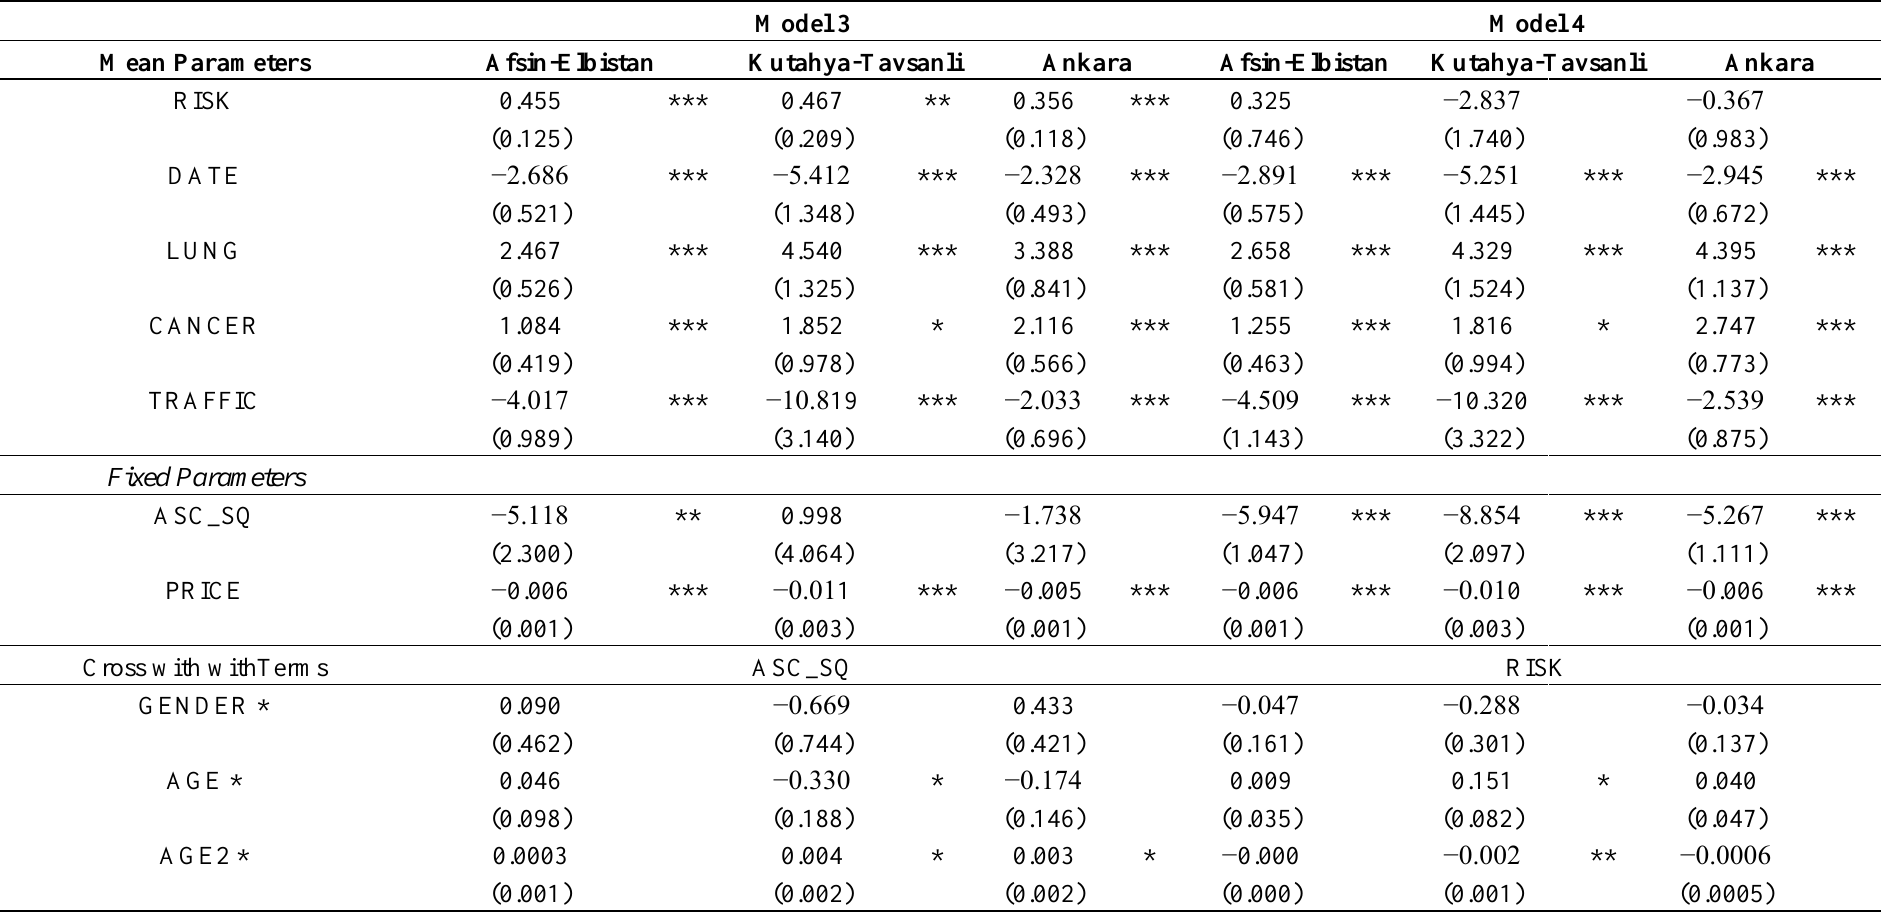
Table 9. Estimated Results for Model 3 (ASC_SQ Cross Terms) and 4 (RISK Cross